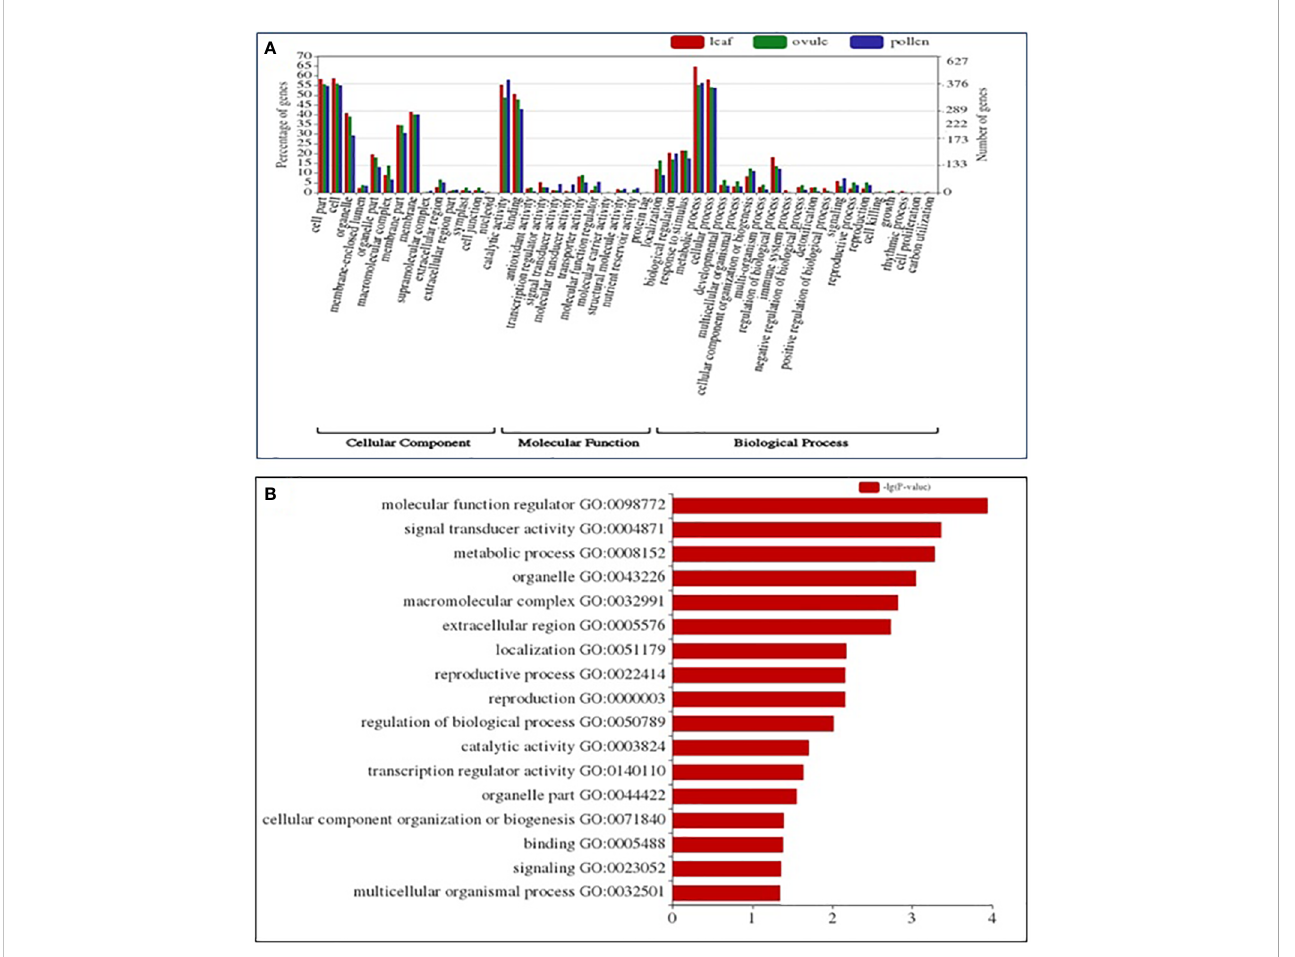
FIGURE 3 GO and KEGG enrichment analysis of DEGs identi fi ed in the comparison of leaf, pollen, and ovule of LM 11 (S) and CML 25 (T) under heat stress. (A) GO analysis categorized DEGs into Cellular Component (CC), Molecular Function (MF), and Biological Process (BP). The right Y-axis indicates the number of genes in GO categories. The left Y-axis indicates the percentage of a speci fi c category of genes in that main category. The X -axis de fi nes GO terms. (B) Abundant KEGG enrichment assigned to DEGs in leaf, pollen, and ovule, collectively under heat